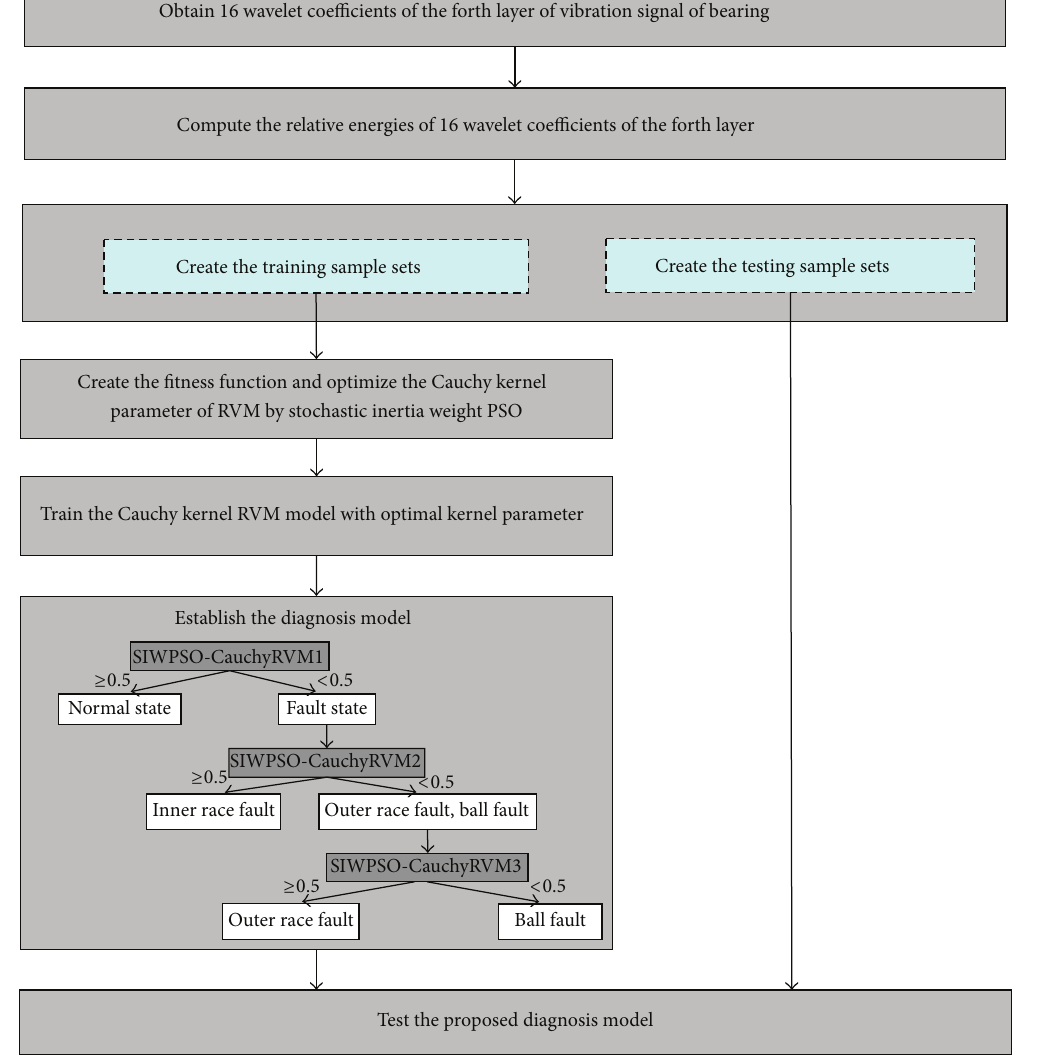
Figure 1: Fault diagnosis process of bearing based on Cauchy kernel relevance vector machine with stochastic inertia weight PSO.